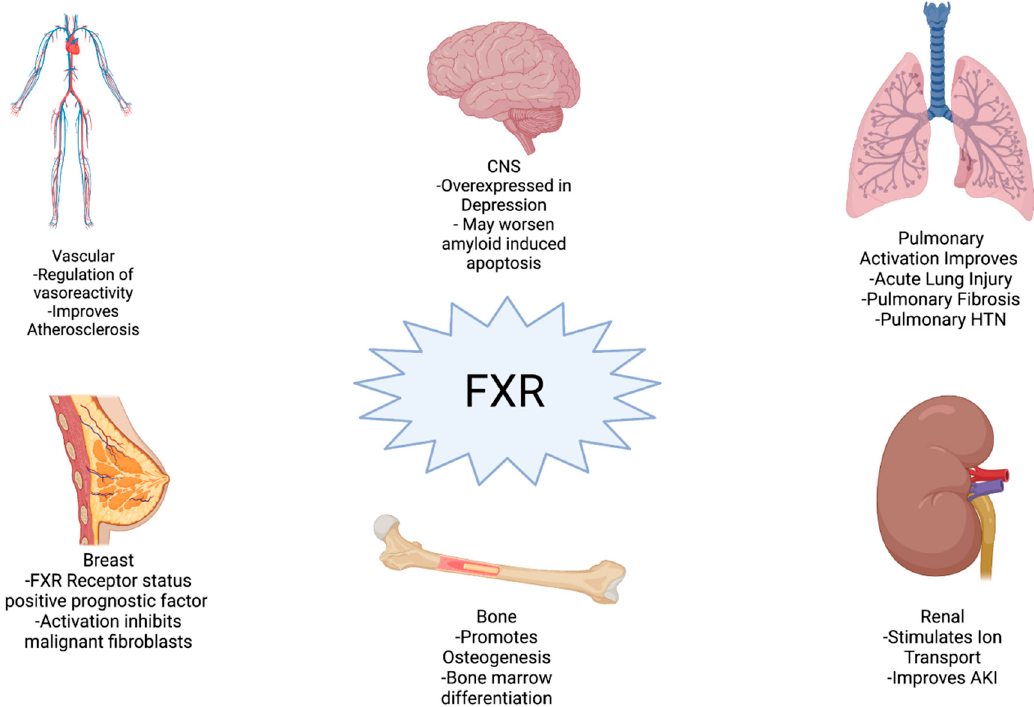
Figure 1. Diverse organ system effects. FXR has functions in many organ systems throughout the body outside the GI–liver axis. In many systems FXR promotes positive effects while its effects in the CNS provide counter examples of potential FXR-induced damage (created with BioRender.com, accessed on 10 October 2021) [19,21–25,27,34–40].